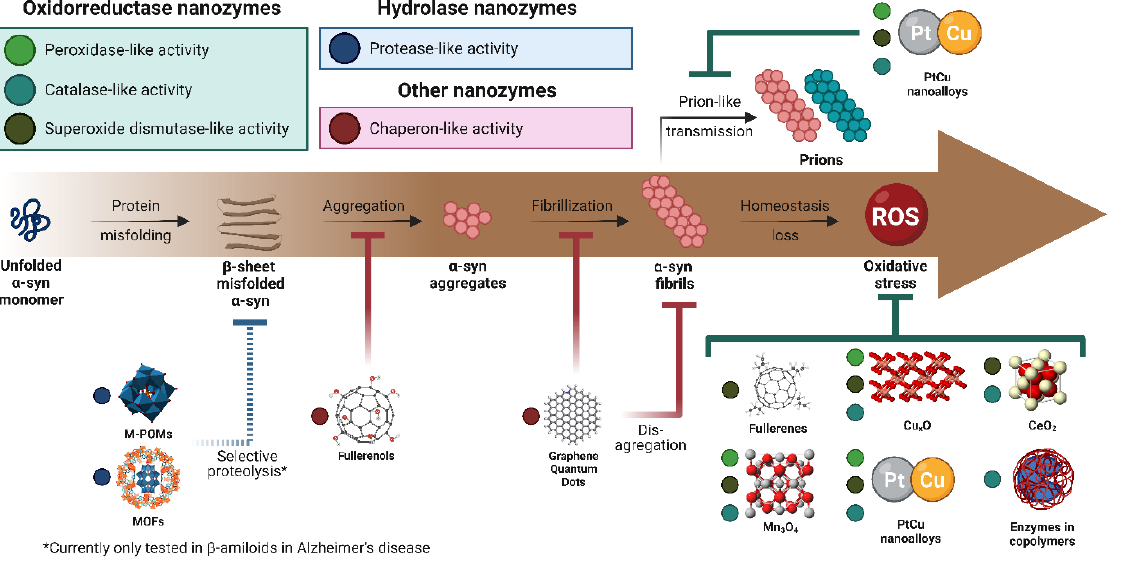
Figure 5. Current research on nanozymes for oxidative stress reduction, protein aggregation inhibition, and selective proteolysis of misfolded alpha-synuclein. Nanozyme research and their application in the different stages of the pathological loss of proteostasis observed in Parkinson’s disease. Enzyme-like activities are depicted in different colors, and nanozymes with oxidoreductase-, hydrolase, and other-like activities are presented inhibiting their target. * M-POMs and MOFs selective protease- like activities have only been observed for β - amyloids in Alzheimer’s disease. ROS: reactive oxygen species; α -syn: alpha-synuclein; M-POMs: metal-substituted polyoxometalates; MOFs: metal-organic frameworks; Pt: platinum; Cu: copper; Cu x O: copper oxide; CeO 2 : cerium dioxide; Mn 2 O 4 : manganese oxide. Figure made in BioRender.com.